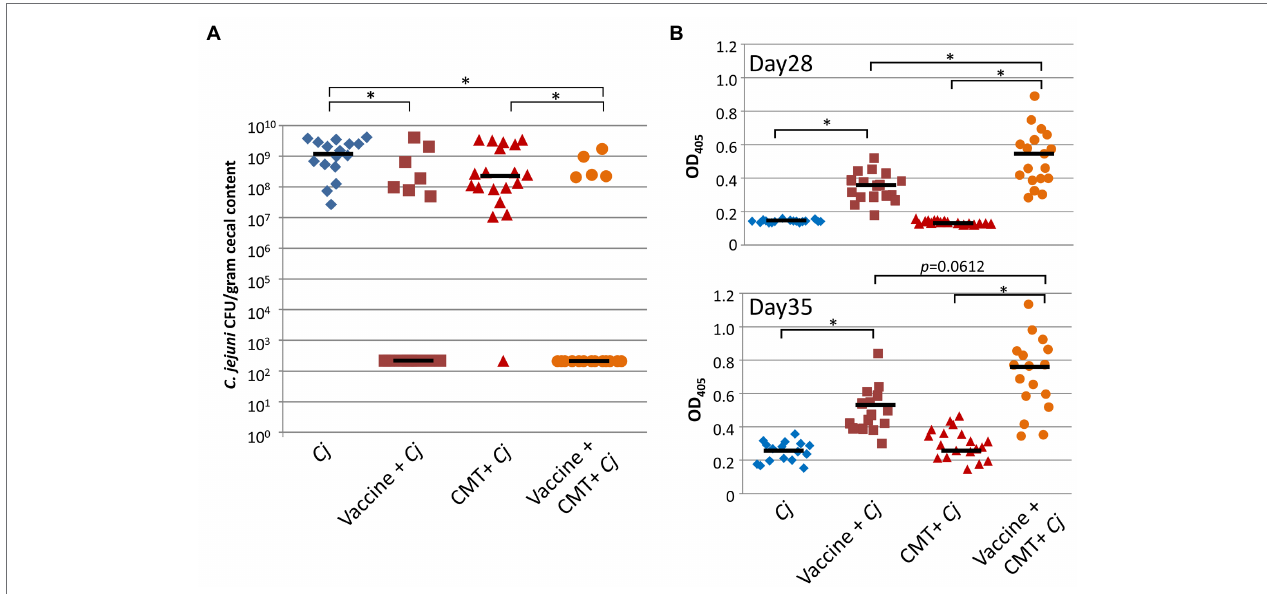
FIGURE 6 | Cecal bacteria isolated from protected birds significantly improve vaccine performance. Combined results from two independent 35-day broiler vaccination studies. (A) Colonization of 35-day-old broiler birds . C. jejuni colonization [expressed as colony forming units (CFU) per gram of chicken cecal contents] after vaccination with 1 × 10 8 live E. coli vaccine co-administered with cecal bacteria (Vaccine + CMT + Cj , n = 18) compared to birds that received the live E. coli vaccine alone (Vaccine + Cj , n = 15). To deplete the microbiota birds in the Vaccine + CMT + Cj as well in the cecal bacteria challenge control (CMT + Cj , n = 19) groups, birds received antibiotics in the drinking water for 3 days prior to vaccination/cecal microbiota transplantation. Birds in the positive control group ( Cj , n = 16) were not vaccinated but challenged with 1 × 10 6 C. jejuni 81-178 on day 28. Statistically significant differences between groups (Fisher’s exact test, p < 0.001) are indicated by an asterisk. (B) The N-glycan-specific immune responses. ELISA results using a 1:10 dilution of chicken sera from bleeds taken before challenge (day 28, upper panel) and at the day of euthanasia (day 35, lower panel). Each point represents the N-glycan-specific IgY antibody response measured at OD 450 for each individual chicken. Black bars represent the median for each group. Statistically significant differences between groups (two-tailed t -test, p < 0.05) are indicated by an